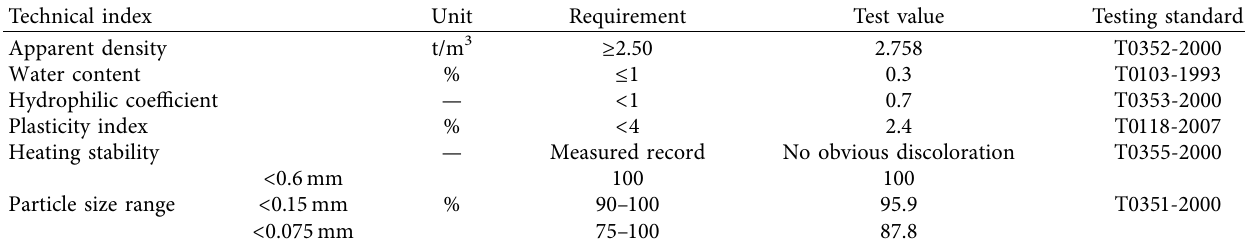
Table 3: Basic indexes of filler.